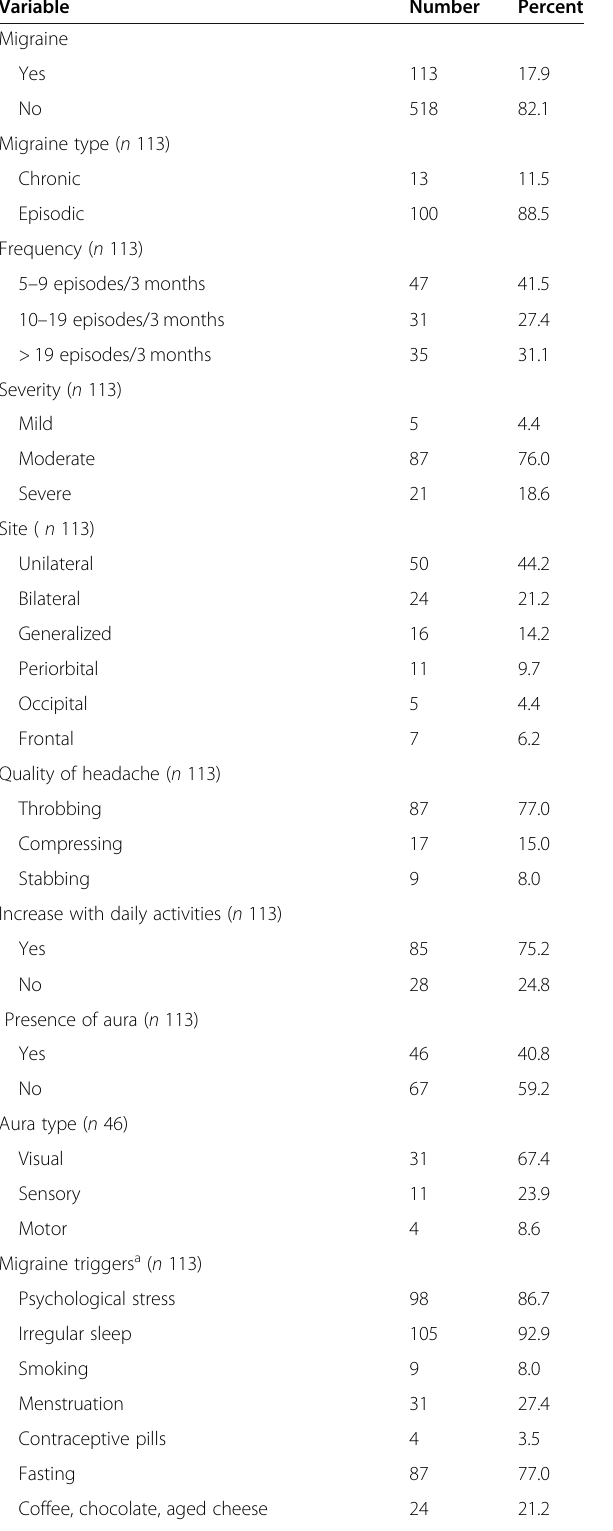
Table 2 Frequency and characteristics of migraine among the students under study